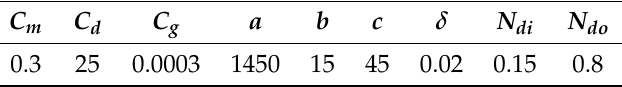
Table 3. Parametric values of scaling and shape parameters.